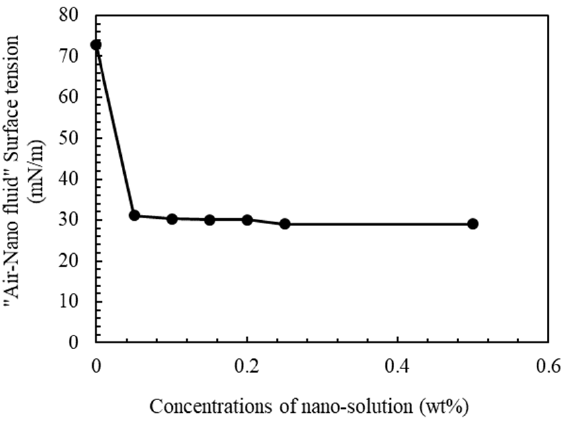
Figure 15. Surface tension test of different concentrations of nano-solution.